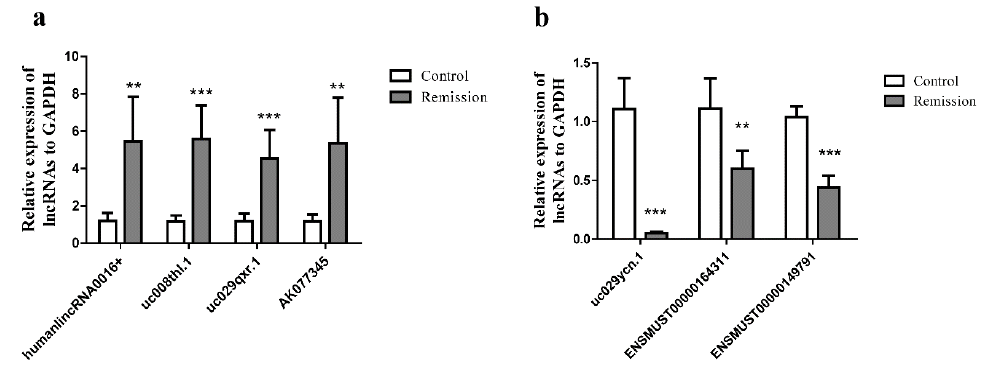
Figure 8. Confirmation of microarray results in the same samples from the ear tissue homogenate in the remission phase of the AD recurrence model. ( a , b ) lncRNAs humanlincRNA0016+, uc008thl.1, uc029qxr.1, AK077345, uc029ycn.1, ENSMUST00000164311, and ENSMUST00000149791 were detected by qRT-PCR (mean ± SD, n = 3, ** p < 0.01, *** p < 0.001 versus A).